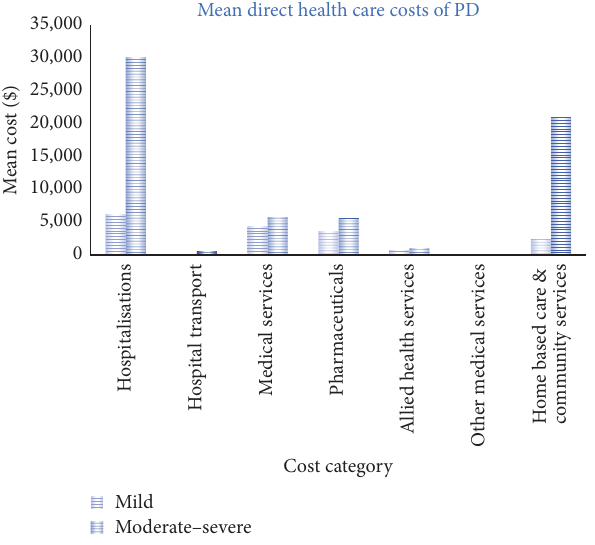
Figure 2: Cost of Parkinson’s disease per year per person.